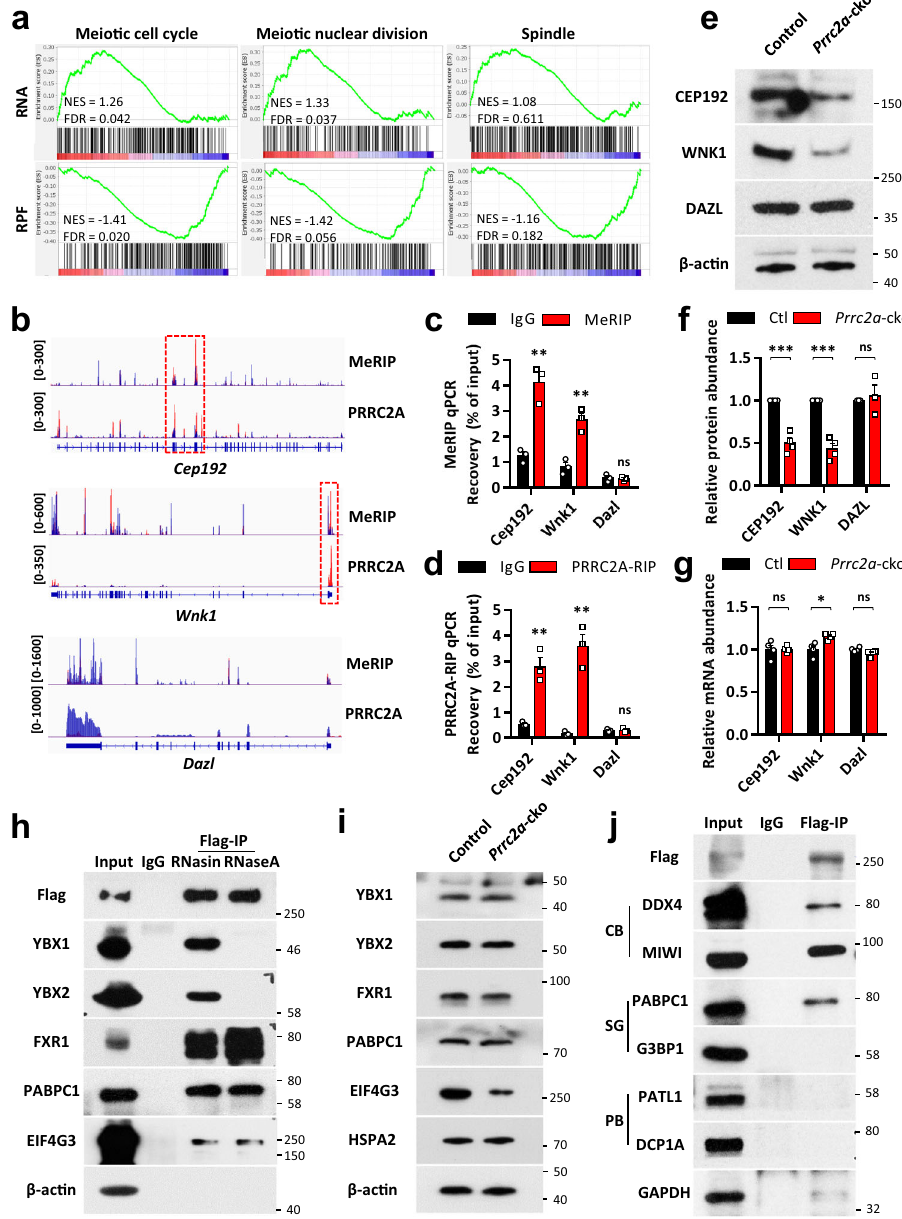
Fig. 7 | PRRC2A promotes the expression of genes involved in meiotic cell division. a GSEA analysis of indicated gene sets in RNA-seq and Ribo-seq data ( Prrc2a -ckoversuscontrol). b IntegrativeGenomicsViewershowedthedistribution ofm6A-modi fi edpeaksandPRRC2A-bindingpeaksalongwithindicatedtranscripts inPRRC2ARIP-seqandm6A-seq 11 data.Bluepeaksandredpeaksrepresentreadsin the input and IP groups, respectively. Red boxes show the area containing both m6A-modi fi ed peaks and PRRC2A-binding peaks. c , d MeRIP-qPCR and PRRC2A RIP-qPCR analysis of indicatedtranscripts inP20 testes. Two-sided student ’ s t -test. Errorbars, n =3biologicalrepeats, mean±SEM. ns p >0.05, ** p <0.01. Source data are provided as a Source Data fi le. e WB test of indicated protein in control and